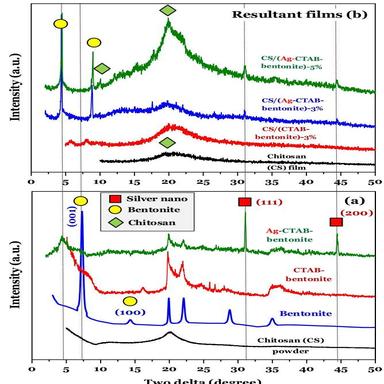
XRD patterns of various (a) feedstock materials and (b) resultant films.